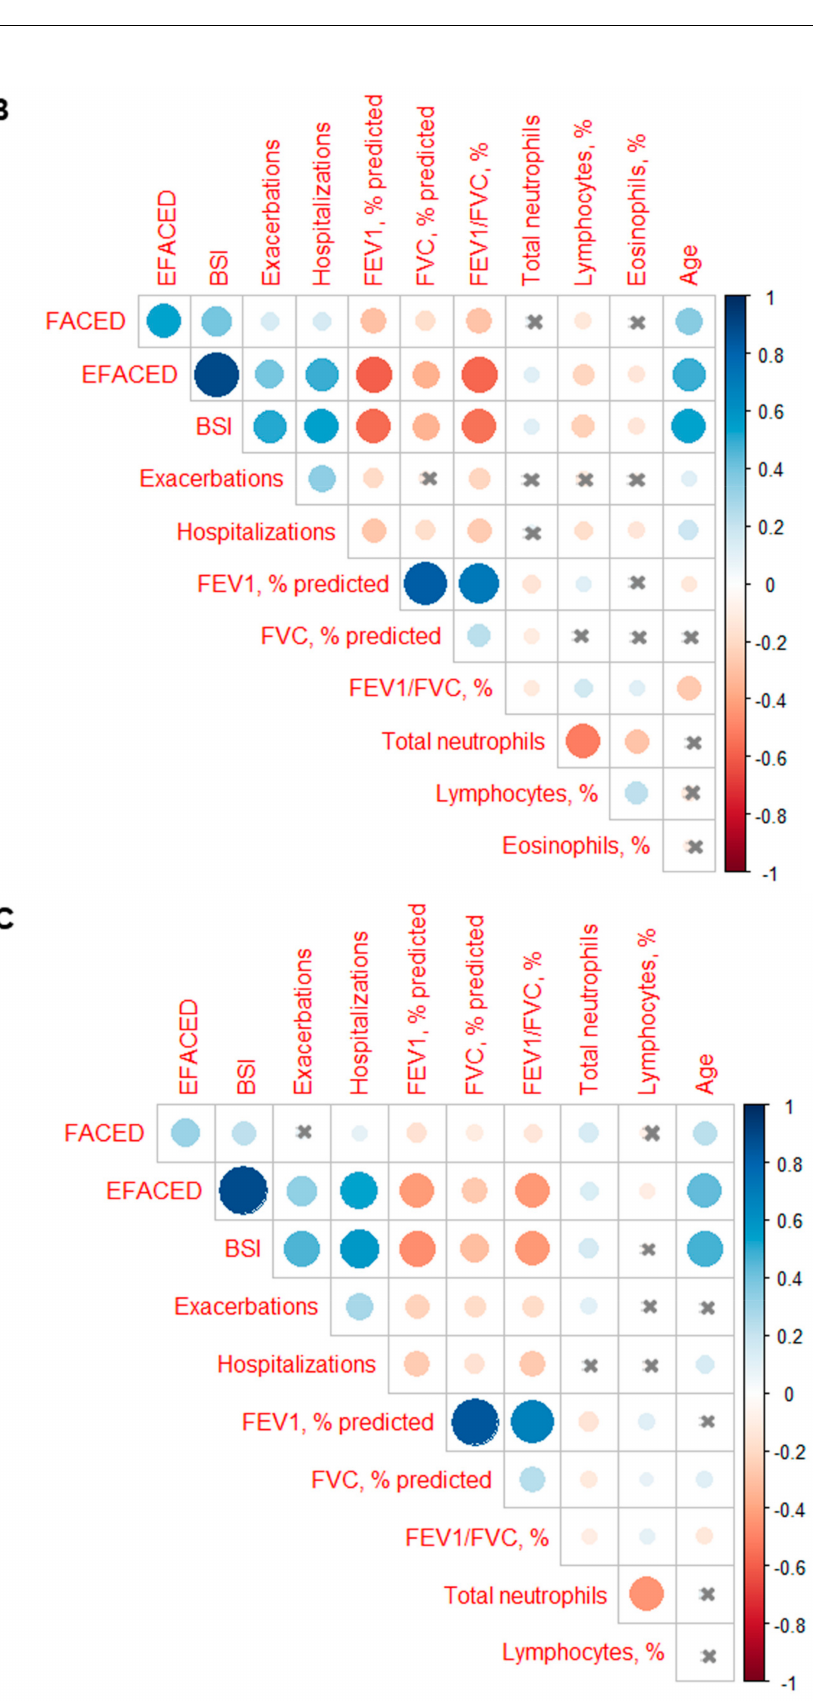
Figure 4. Correlation matrix of the disease severity and analytical variables in which blue dots indicate the existence of a positive correlation between two variables, while the red dots